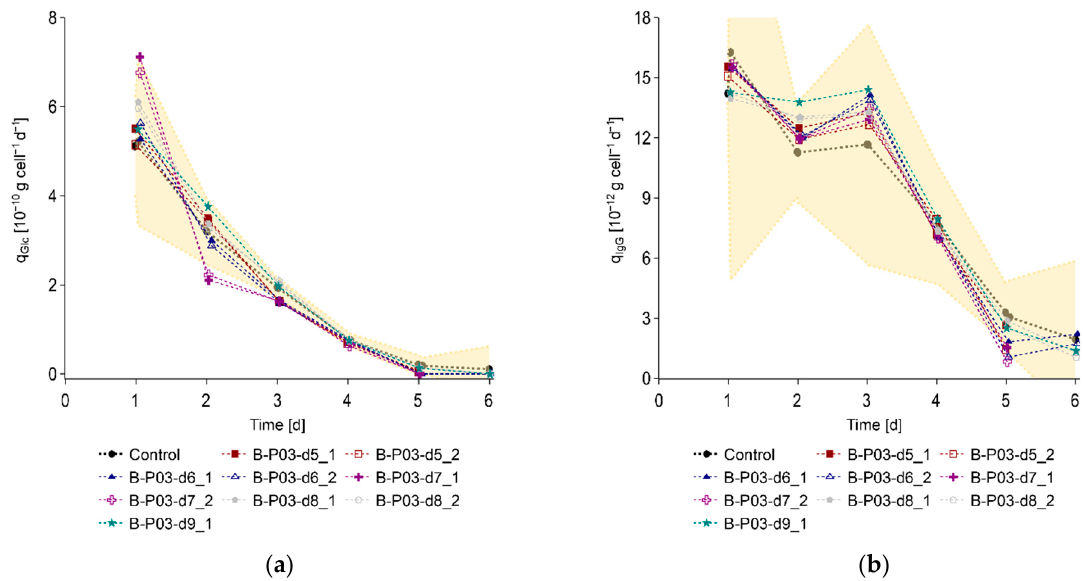
Figure A3. Course of ( a ) glucose consumption rate, and ( b ) IgG production rate during the batch experiments inoculated from perfusion cultivation (nomenclature: B = Batch, P03 = Source of inocu- lum, d5–d9 = day of cell harvest from P03). Control: batch experiments inoculated from P03 on days 3 and 4 ( n = 4).